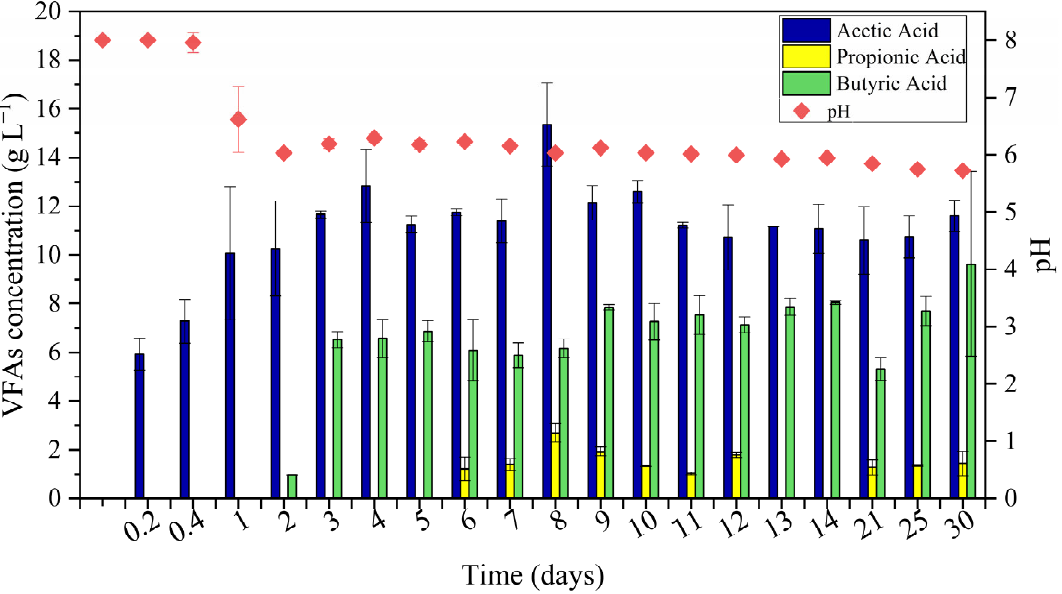
Figure 6. The concentration of carboxylic acids and pH of the fermentation medium on the monitored days.